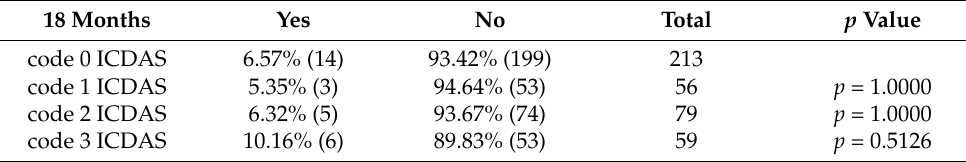
Table 8. Presence of carious lesions at 18 months.